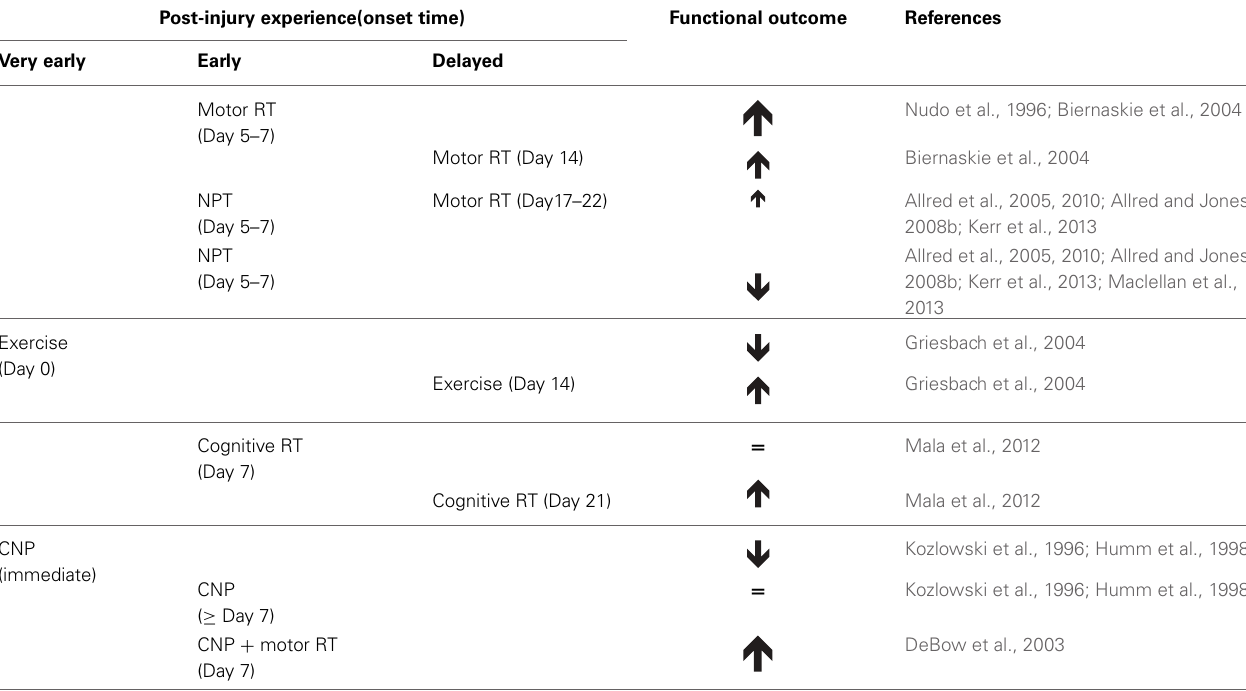
Table 1 | Time-sensitive effects of behavioral manipulations on functional outcome after brain damage in animal models. Post-injury experience(onset time) Functional